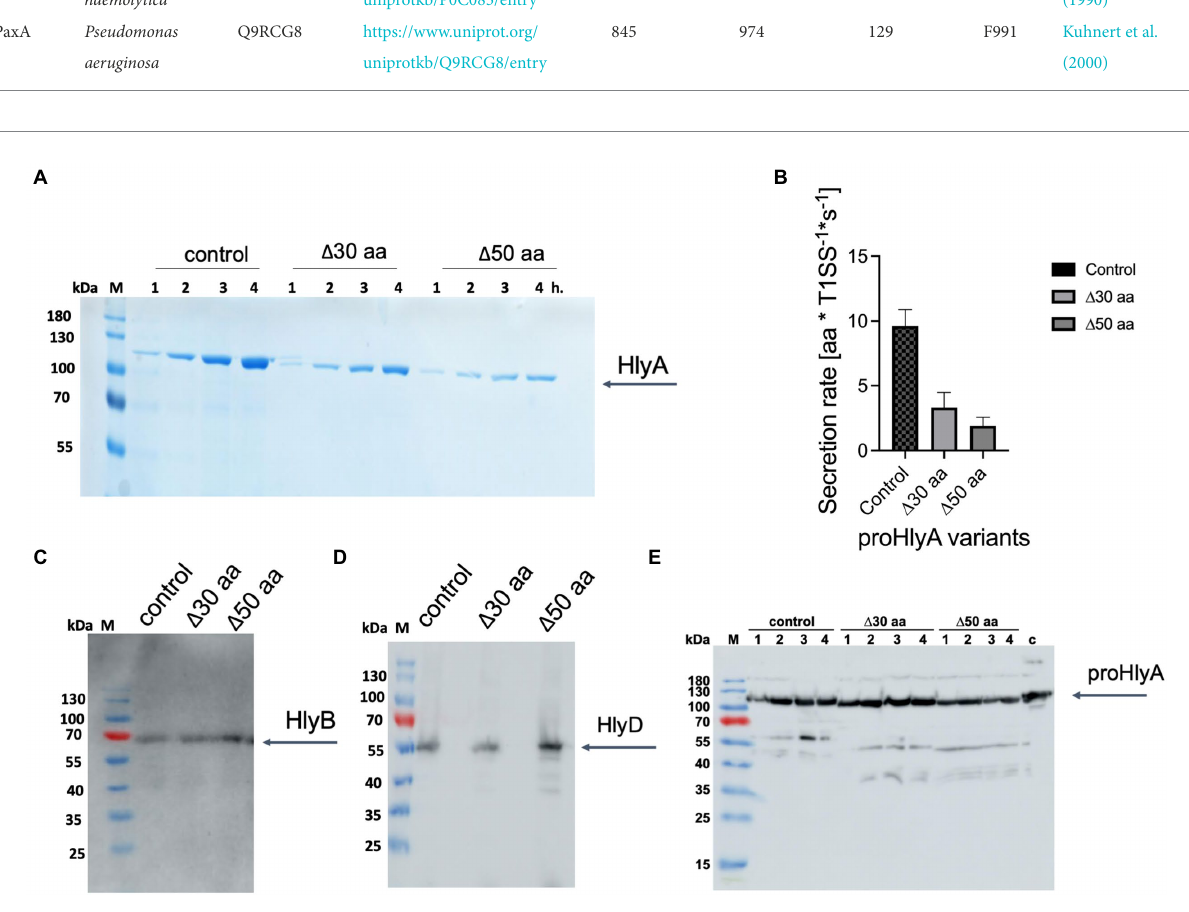
FIGURE 6 Secretion of proHlyA variants through the HlyA T1SS. (A) SDS-PAGE analysis of the supernatant (unconcentrated) of clones secreting wild type proHlyA (control), 30-residues-truncated proHlyA ( Δ 30 aa), and 50-residues-truncated proHlyA ( Δ 50 aa) through the HlyA T1SS. (B) Secretion rates of truncated proHlyA. Error bars represent the standard deviation of at least three biological replicates. Western blot analysis of E. coli cells demonstrated that the amounts of (C) HlyB, (D) HlyD or (E) proHlyA were expressed for cells secreting either WT proHlyA, 30-residues- truncated proHlyA, or 50-residues-truncated proHlyA in comparable levels. M, marker proteins; the molecular weight of the marker proteins is given on the left; x h., unconcentrated supernatant of culture, where x denotes the number of hours after